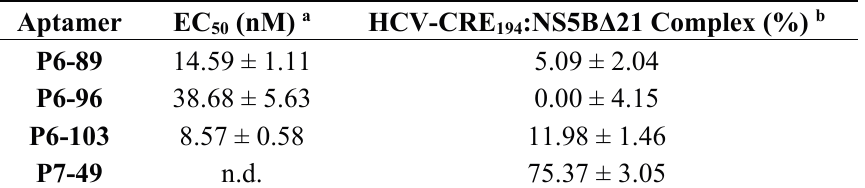
Figure 5. Competition of the interaction NS5B Δ 21:CRE with the selected aptamers. The internally 32 P-labeled HCV-CRE 194 construct was incubated with a molar excess of the recombinant viral polymerase NS5B Δ 21 and increasing concentrations of the aptamers under study, P6-86, P6-96, P6-103, and P7-49. Glycogen was used as a control of the competition reaction. Data were fitted to a non-linear equation to calculate the EC 50 value. Values are the mean ± the standard deviation of four independent experiments. Table 3. EC 50 values for the competition of the interaction NS5B Δ 21: CRE with the aptamers P6-89, P6-96, P6-103, and